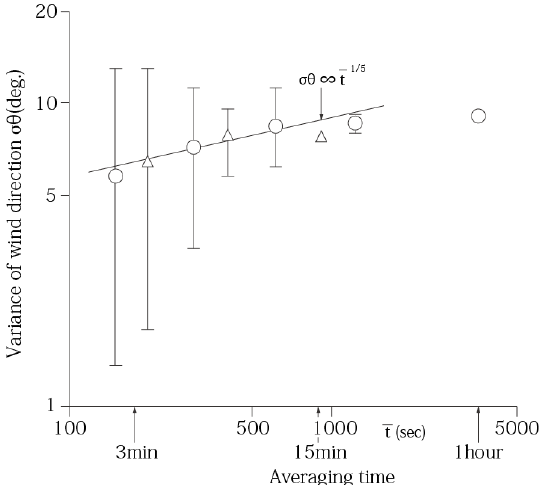
Figure 9. The dependence of the variance of wind direction on average time [17].